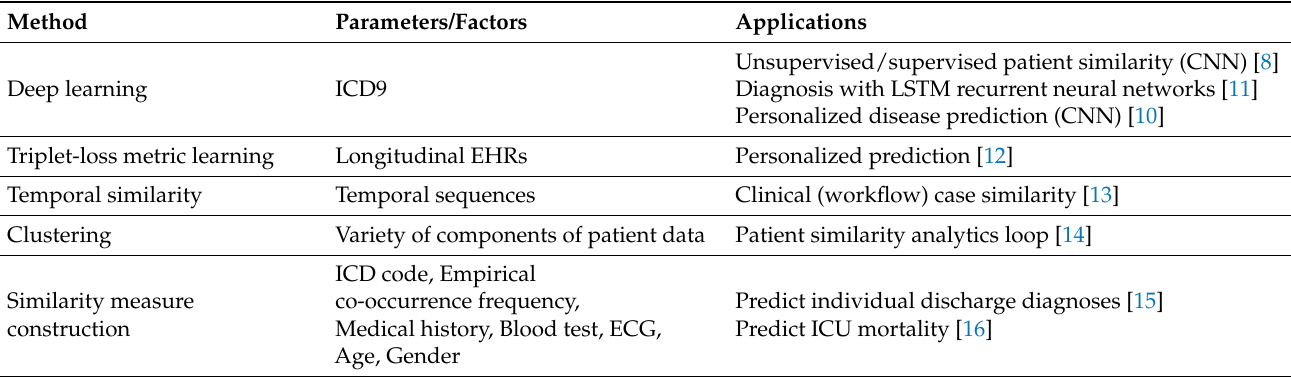
Table 1. Methods used for building patient